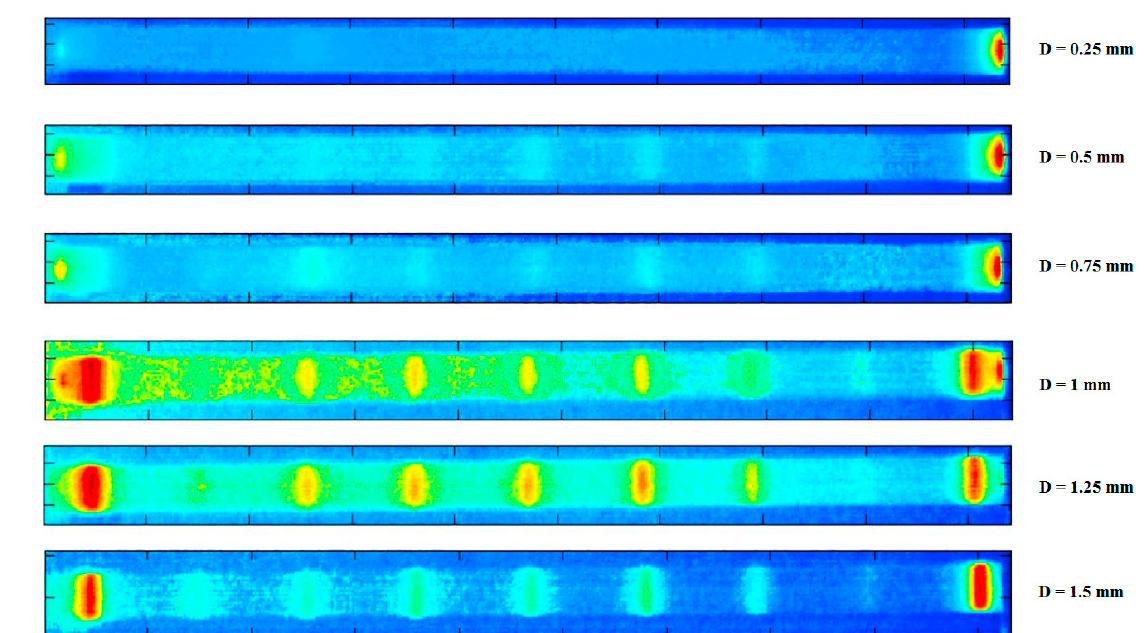
Figure 46. The exemplary results of defect detectability for notch-type damage with different depths using the SHVT method, adapted with permission from Ref. [138]. Copyright © 2018 Elsevier